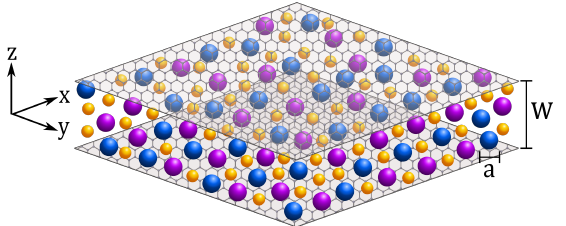
Figure 3. IL-solvent mixture confined in a slit-shaped mesopore. The electrodes are separated by a distance w , and the electrostatic potential, U , applied at z = 0 and z = w is kept constant with respect to the bulk. The ion diameter, denoted by a , is the same for cations (blue) and anions (purple spheres). Yellow spheres represent the solvent. The ionophilicity (or surface field) at z = 0 and z = w is denoted by h s and describes the electrode preference for ions or